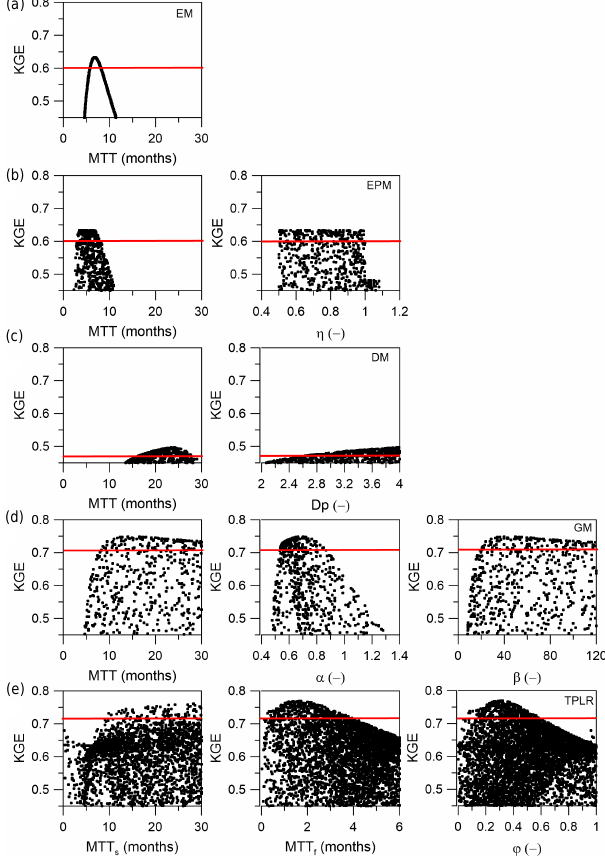
Figure 4. Monte Carlo simulations of the fitted parameters of the five lumped parameter models used to simulate the δ 18 O stream- flow composition at the outlet of the basin (M8). (a) EM; (b) EPM; (c) DM; (d) GM; and (e) TPLR. The ( − ) symbol on the x axes denotes that the fitting parameter is dimensionless. Horizontal red lines indicate the threshold of behavioral solutions (at least 0.95 of maximum